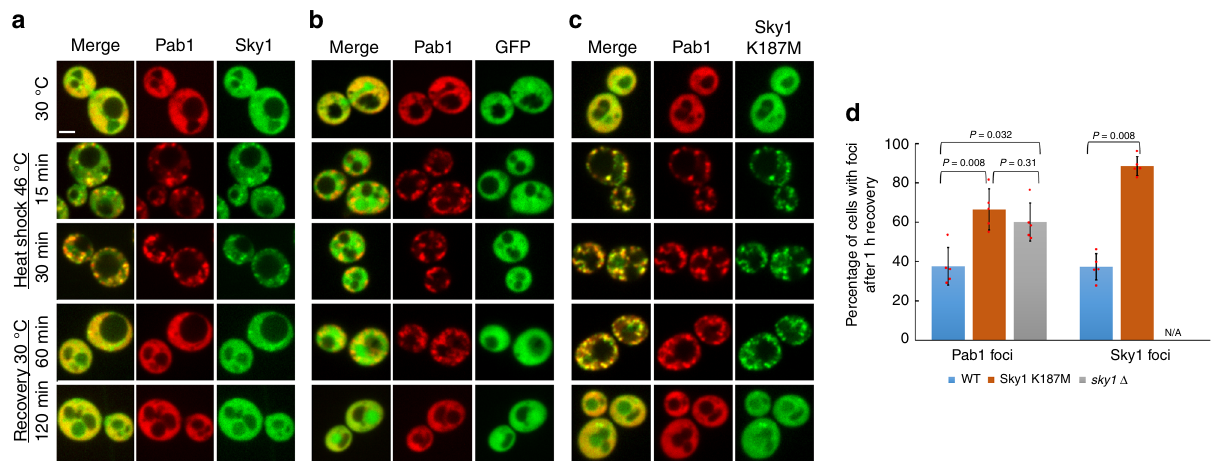
Fig. 4 Sky1 ’ s kinase activity is required for ef fi cient stress granule dissolution. In yeast strains expressing Pab1-mCherry from the endogenous PAB1 locus, the SKY1 open reading frame was replaced with SKY1 -GFP ( a ), the GFP open reading frame ( b ), or a catalytically inactive sky1 K187M -GFP allele ( c ). Cells were grown to mid-log and visualized by fl uorescence microscopy during heat shock and recovery. Scale bar, 2 μ m. d Quanti fi cation of the percentage of cells containing Pab1 foci or Sky1 foci in wild-type (blue), sky1 K187M (orange), or Δ sky1 (gray) cells. Data represent means ± SD of n = 5 independent replicates. A two-sided Mann – Whitney U test was used to calculate P values. Source data are provided as a Source Data fi